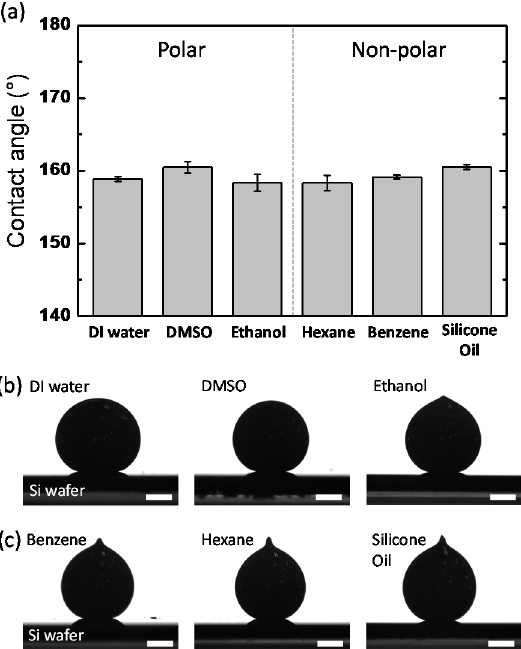
Figure 1. ( a ) Contact angles of EGaIn droplets on a Si wafer in polar and non-polar solvents. ( b , c ) Side-view images of EGaIn droplets placed on a Si wafer in ( b ) polar and ( c ) non-polar solvents. The scale bars are 0.5 mm. The contact angles were measured at 20 °C.